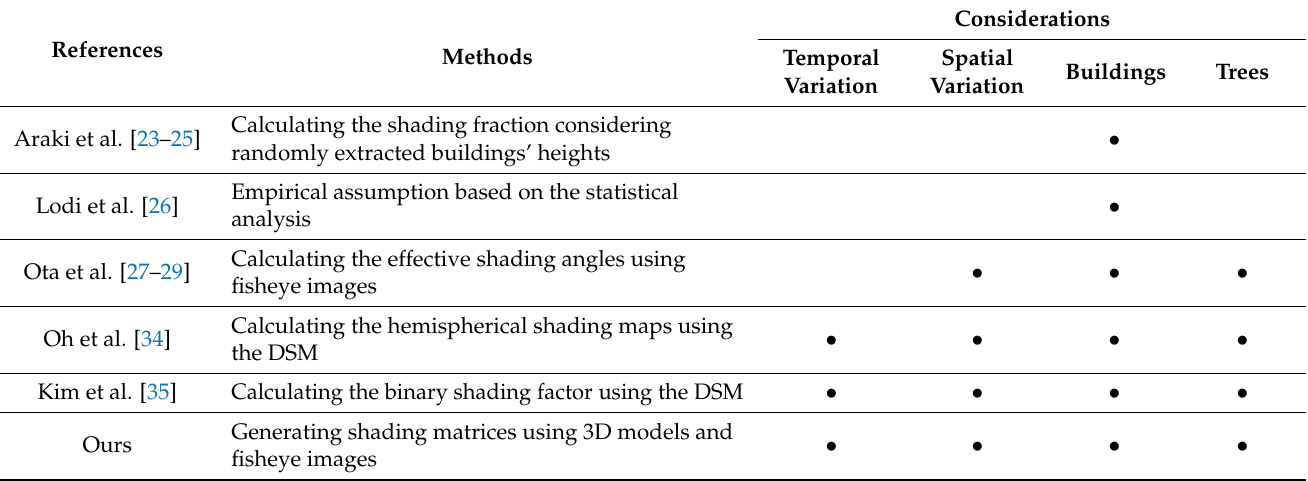
Table 7. Comparison of shading effect calculation methods of this study and previous